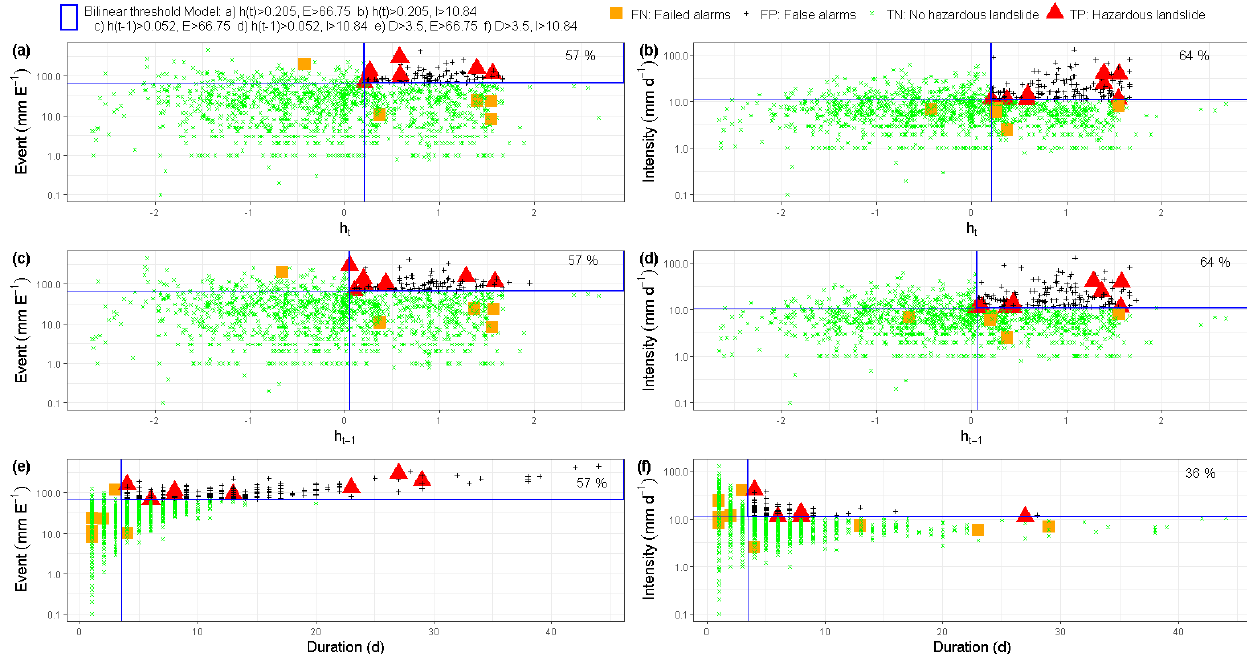
Figure 7. Landslide warning capabilities of the hydro-meteorological and precipitation threshold models: (a) h t – E , (b) h t – I , (c) h t − 1 – E , (d) h t – E , (e) E – D , and (f) I – D in Kivu